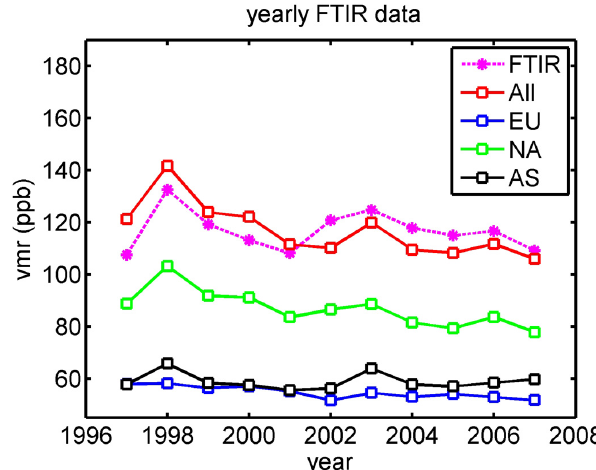
Fig. 11. Yearly mean ground-based in situ CO data (NDIR) as well as model simulated CO mixing ratios above the Jungfraujoch. All, corresponds to the global model simulations, while EU, NA and AS are the model contributions from Europe, North America and Asia, respectively. The fitted 46.6ppb background has been added to all model output (also the regional ones).